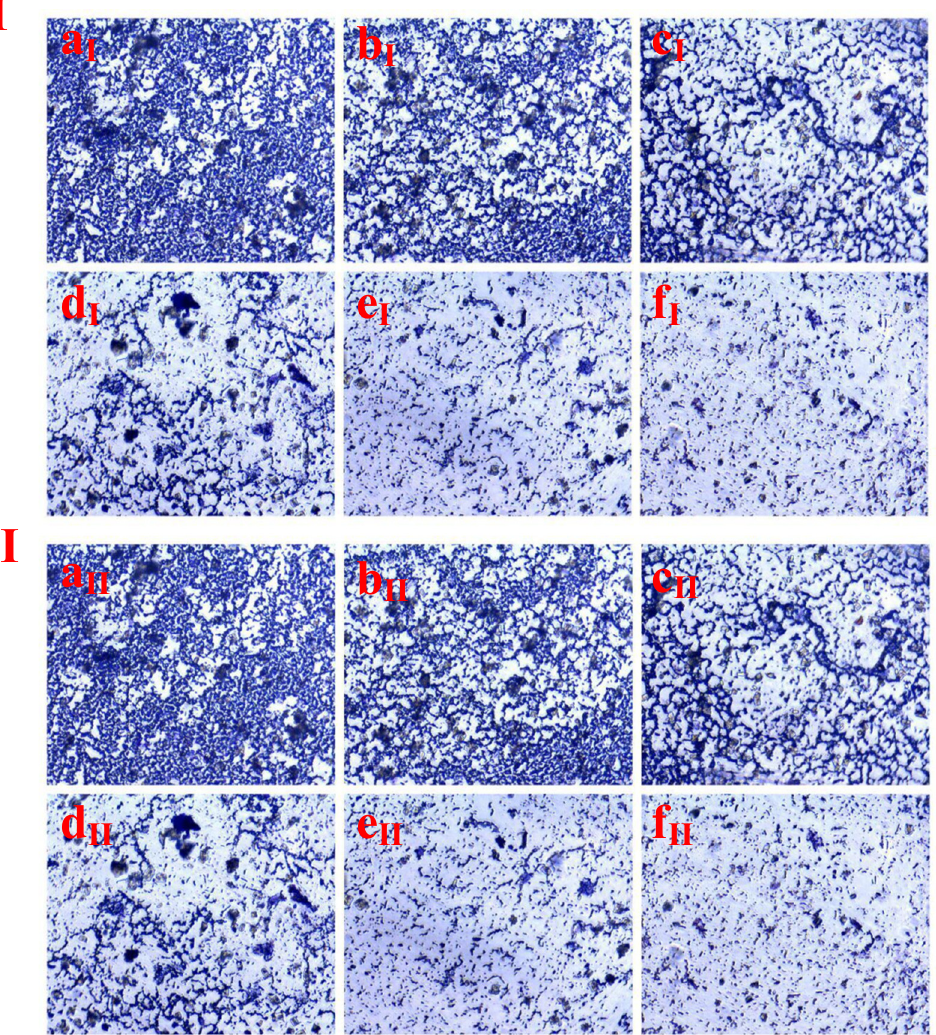
Figure 9: Light microscopic observation ( 40 ×) of S. aureus ( I ) and S. epidermidis ( II ) adhesion phases on the glass surfaces with di ff erent concentration (( a ) control, ( b ) 25 μ g · mL − 1 , ( c ) 50 μ g · mL − 1 , ( d ) 75 μ g · mL − 1 , ( e ) 100 μ g · mL − 1 , ( f ) 125 μ g · mL − 1 ) of Z. mays - synthesized AgNPs against control which is indicative of glass surface with uniformly distributed cells stained with crystal